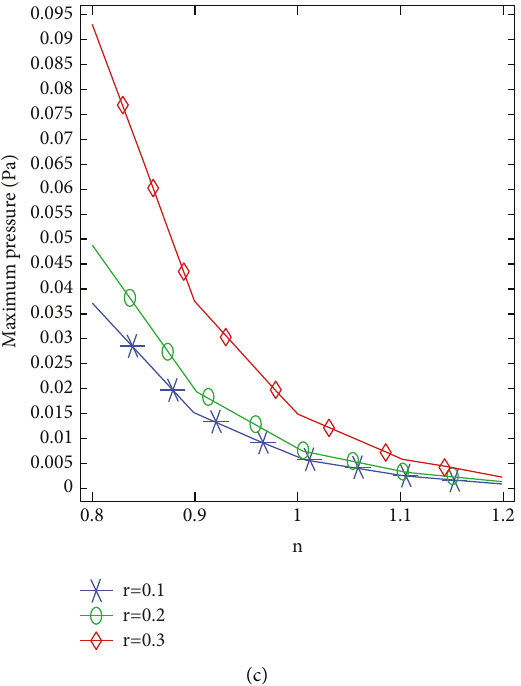
Figure 9: Maximum pressure around the circle: (a) Re � 1000, (b) Re � 4000, and (c) Re �